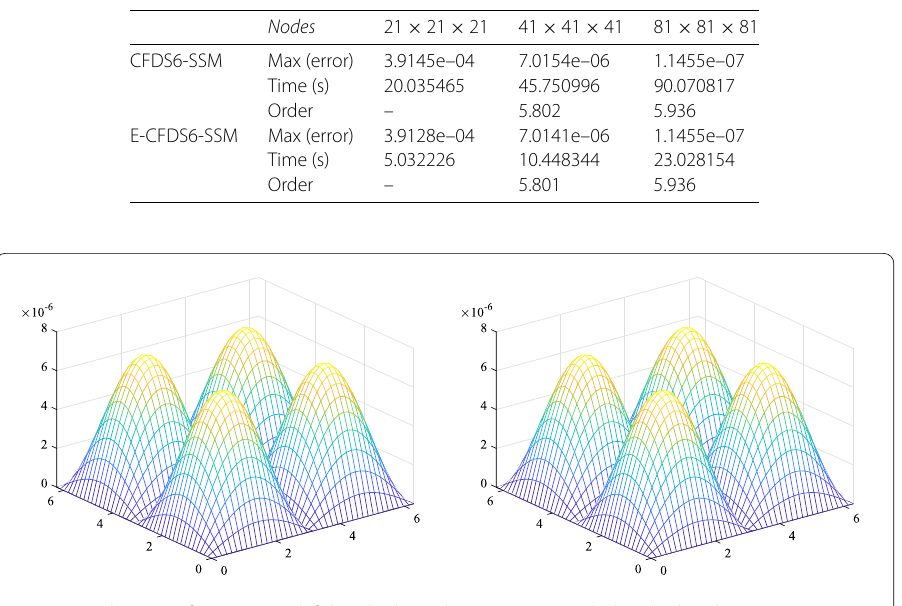
Figure 20 The error of CFDS6-SSM (left-hand side) and E-CFDS6-SSM (right-hand side) when J = 41, z = 0.4 π and t = 1 for SP 6